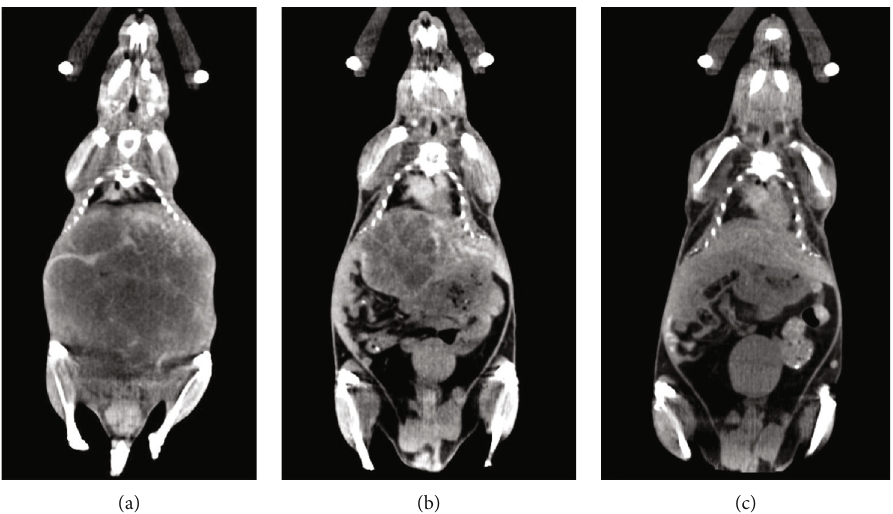
Figure 3: Example of micro-CT con fi rmation of MYC (a) and MET (b) tumors and normal liver (c).